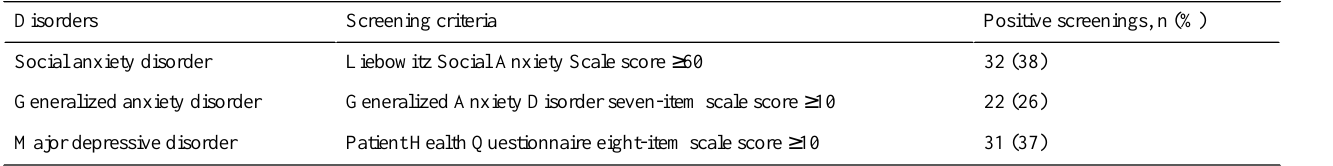
Table 2. Results of screening the study sample for depression and anxiety disorders (n=84).